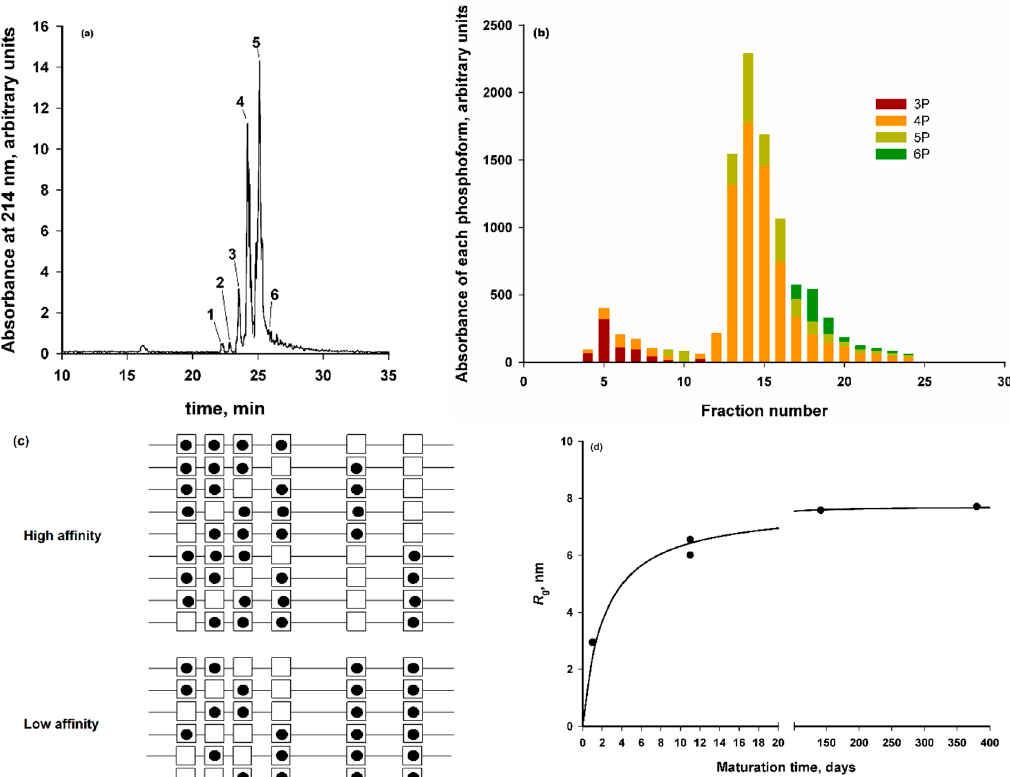
Figure 10. Phosphoforms of CK2-S-6H and nanocluster complexes formed by the high-affinity phosphoforms [40]. ( a ) RP-HPLC of the recombinant purified peptide with numbering corresponding to the total number of phosphorylated sites. Most phosphoforms have 4 or 5 phosphorylated residues. Five sites are in consensus kinase recognition sequences (Table 3) and a small proportion were in a 6-P form. ( b ) Ion exchange chromatography of CK2-S-6H on hydroxyapatite revealed groups of low and high-affinity phosphoforms, mostly separated by the number of phosphorylated residues but sensitive also to positional isomers. ( c ) Schematic rationalization for how the positional isomers of the 4-P phosphoform can occur as either low or high-affinity isomers. In the diagram, filled black circles are phosphorylated sites. The isomers with 3 or 4 phosphorylated residues close together form a high-affinity phosphoform. ( d ) Results from small-angle X-ray scattering measurements of the radius of gyration of nanocluster complexes made with the high-affinity fraction of CK2-S-6H showing the very slow change in the radius of gyration with time for this phosphopeptide.